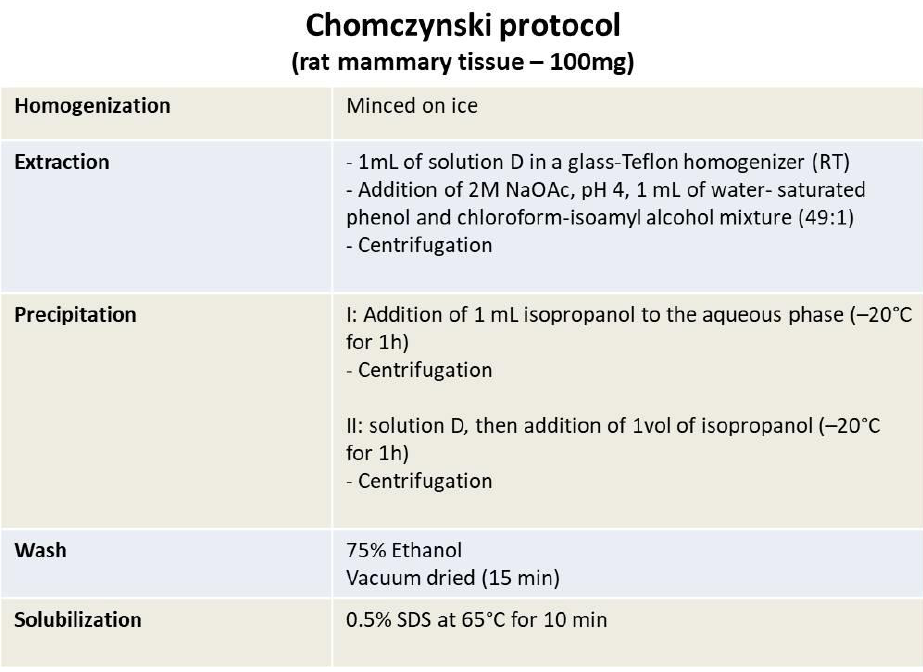
Figure 2. Protocol of RNA isolation by Chomczynski et al. [65]. Table 4. Solutions, temperatures, and times employed in the RNA extraction procedures. ( A )